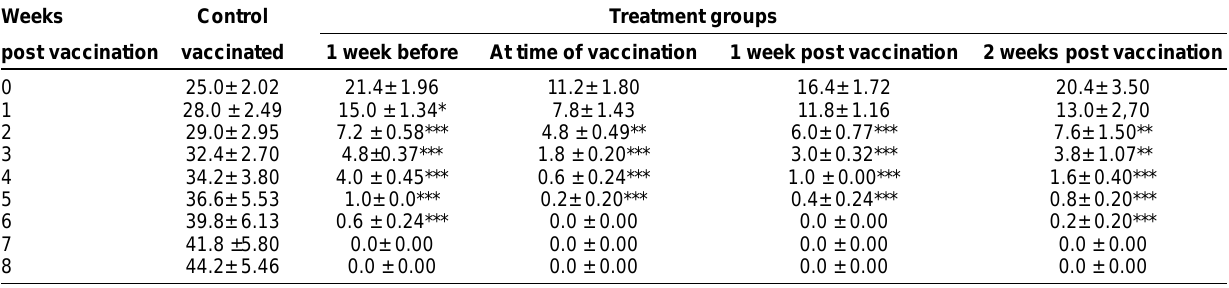
Table-2. Effect of a single intramuscular injection of Imidocarb dipropionate (3mg/Kg b.wt.) on the erythrocyte rosette % in anaplasmosis-infected calves vaccinated with FMD vaccine (±S.D, n=5). Weeks